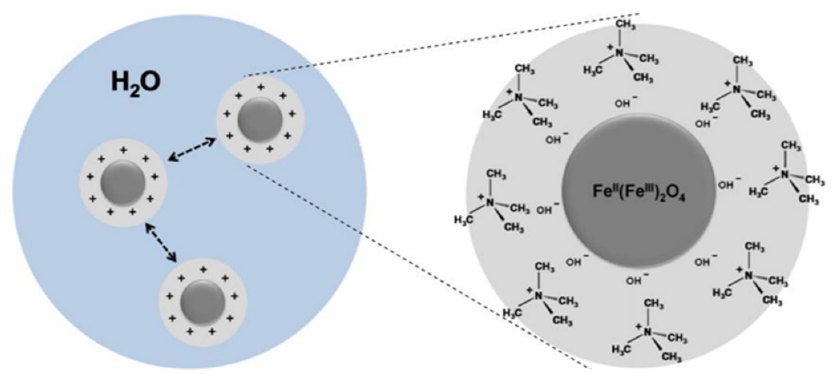
Figure A5 . Schematic representation of magnetite particles suspended in water with a positively charged nanosphere of tetramethylammonium cations.